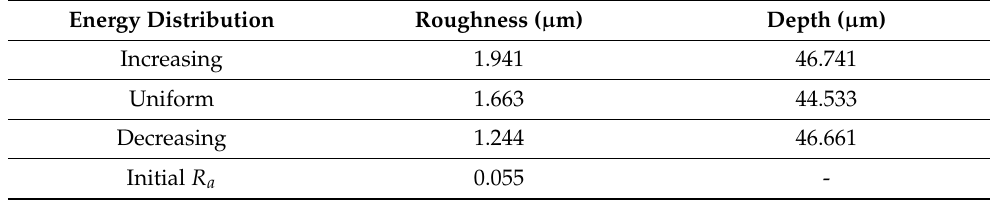
Table A2. Roughness and depth of